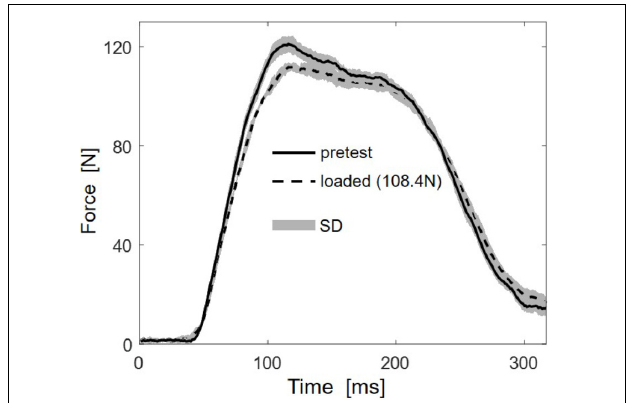
FIGURE 2 | Representative (subject 10) mean force-time traces of five stimulations for the highest load (108.4 N, dashed line) and the five unloaded reference contractions (pretest, solid line). Standard deviations (SD) are shown as gray areas.